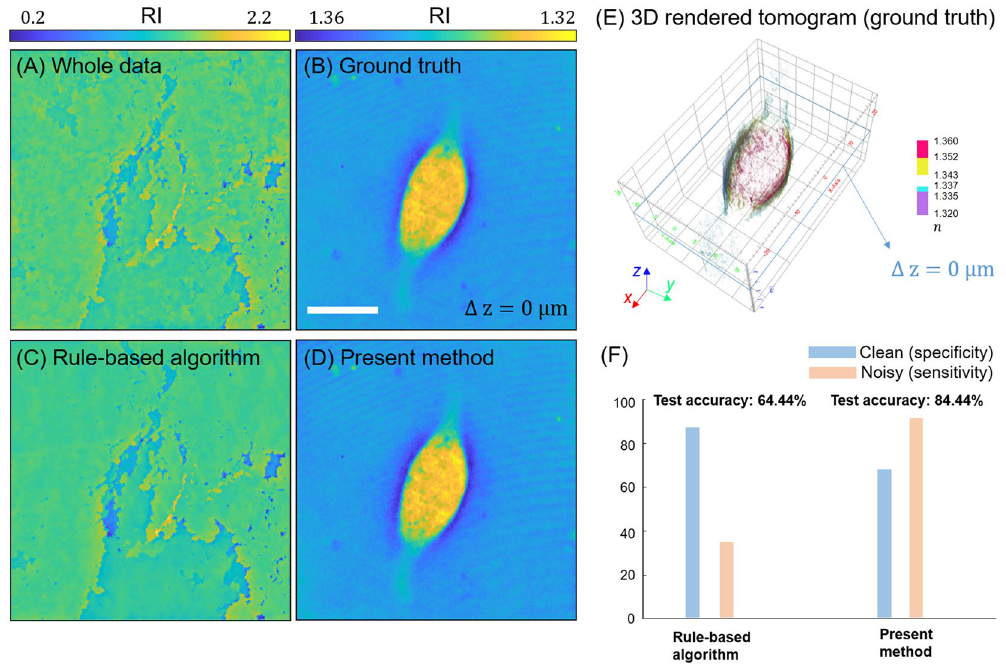
Figure 5. Generalisation test: NIH3T3 cell tomograms (sliced at axial center, Δ z = 0 μ m) are recovered from various classified optical field data from ( A ) all 45 fields, ( B ) ground truth prepared by the expert, ( C ) the rule- based algorithm, and ( D ) the present method. ( E ) 3D iso-surface rendering of the tomogram recovered from the ground-truth optical fields. ( F ) The specificity and sensitivity, along with the total test accuracy, are